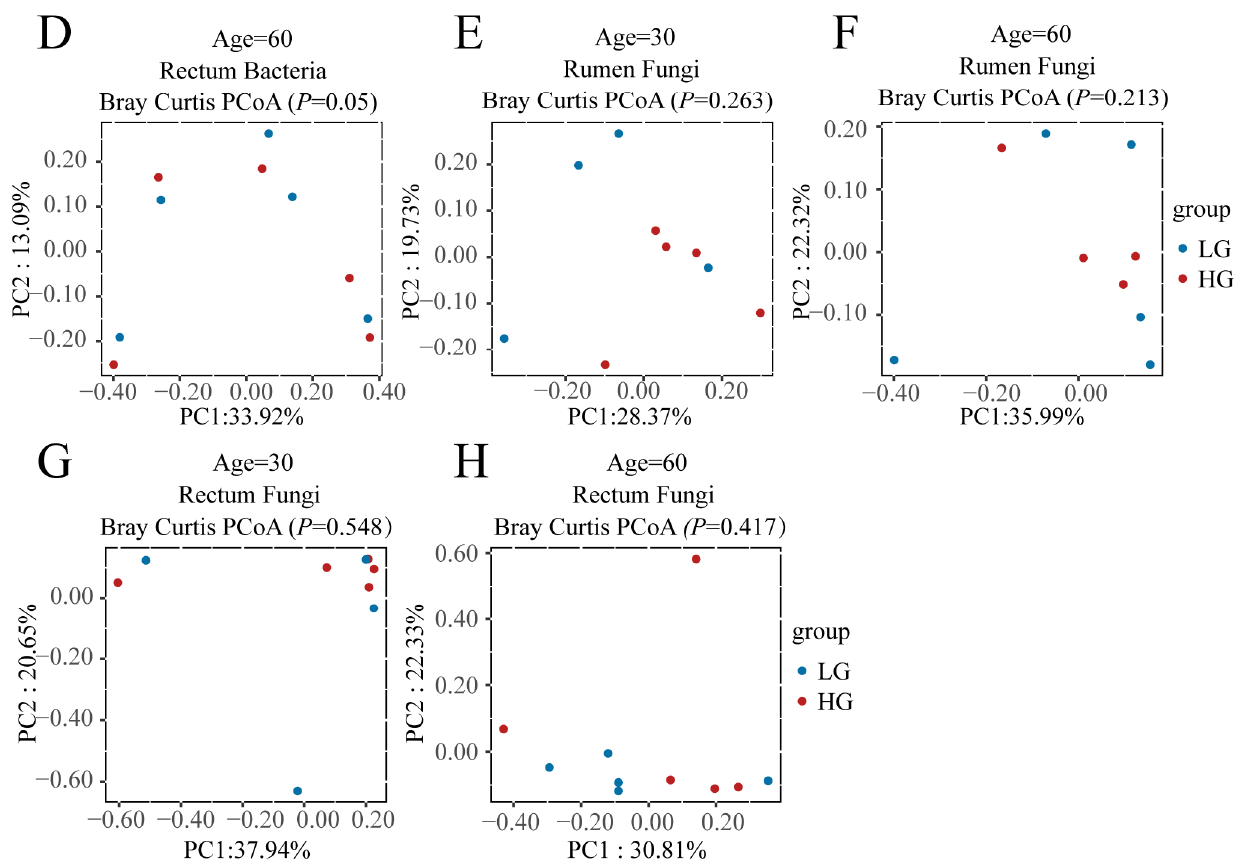
Figure 2. Bacterial and fungal communities and differences between the five lambs with the lower average daily gain (LG) and the five lambs with the higher average daily gain (HG) in the gastroin- testinal tract before weaning. ( A ) Principal coordinate analysis (PCoA) plots of the rumen bacterial communities of LG and HG groups at 30 days of age before weaning. ( B ) PCoA plots of the rumen bacterial communities of LG and HG groups at 60 days of age before weaning. ( C ) PCoA plots of the rectum bacterial communities of LG and HG groups at 30 days of age before weaning. ( D ) PCoA plots of the rectum bacterial communities of LG and HG groups at 60 days of age before weaning. ( E ) PCoA plots of the rumen fungal communities of LG and HG groups at 30 days of age before weaning. ( F ) PCoA plots of the rumen fungal communities of LG and HG groups at 60 days of age before weaning. ( G ) PCoA plots of the rectum fungal communities of LG and HG groups at 30 days of age before weaning. ( H ) PCoA plots of the rectum fungal communities of LG and HG groups at 60 days of age before weaning.